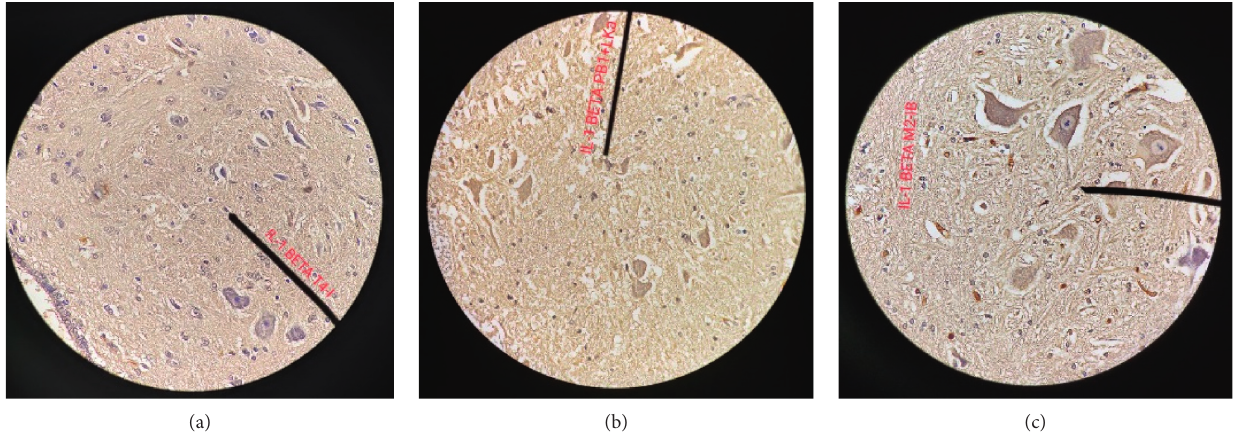
Figure 5: The expression of IL-1 β with an immunohistochemistry technique. Microscopic views under 200x magnification show IL-1 β expression in microglia cells in the control group (a), IL-1 β expression in microglia cells in the AMAN group (b), and IL-1 β expression in microglia cells in the AMAN with HBO group (c). (Black arrows show colored microglia cells brown which gives a positive reaction to anti- IL-1 β monoclonal antibody in the lumbar vertebral bone